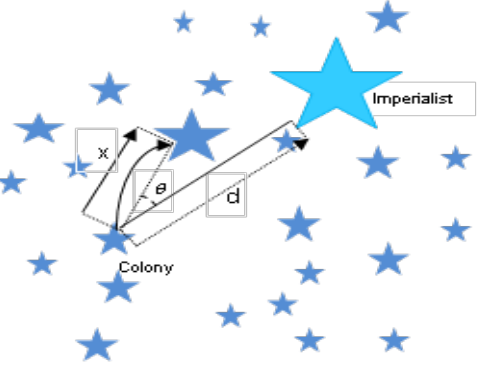
Fig. 5. Colonies move toward the emperors at a random